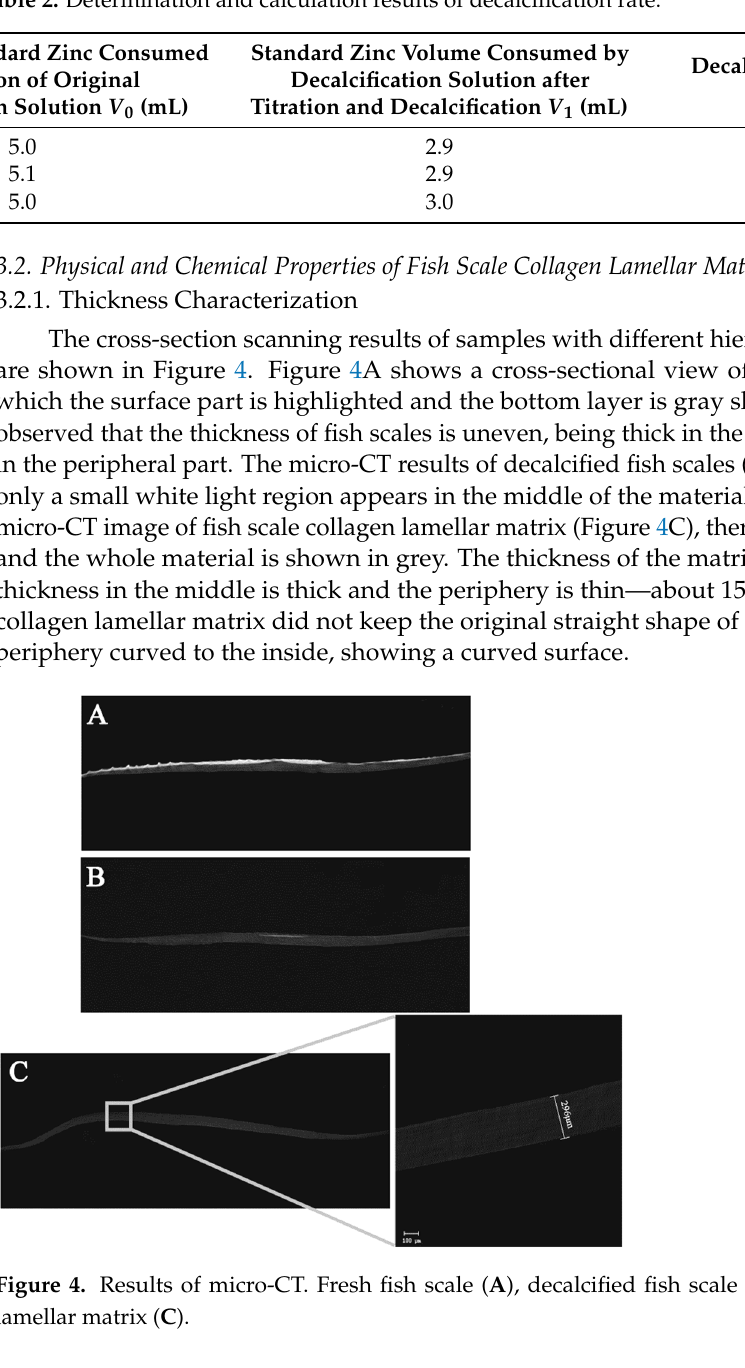
Table 2. Determination and calculation results of decalcification rate.